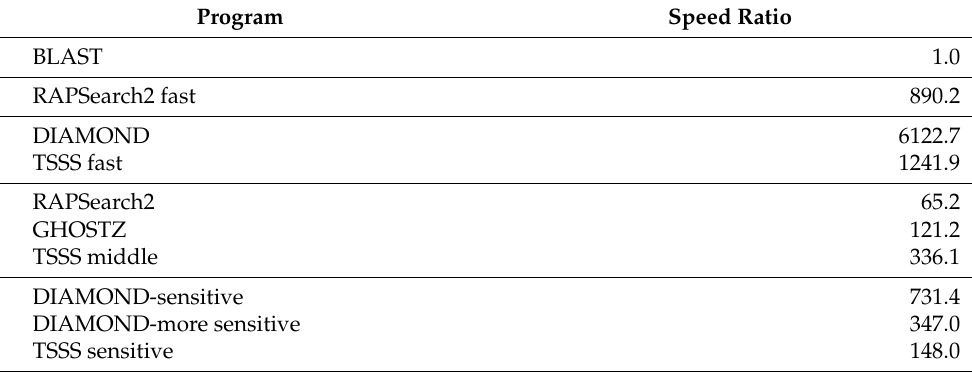
Figure 7. CPU time according to number of queries for each program. Table 5. Execution speed ratio against NCBI